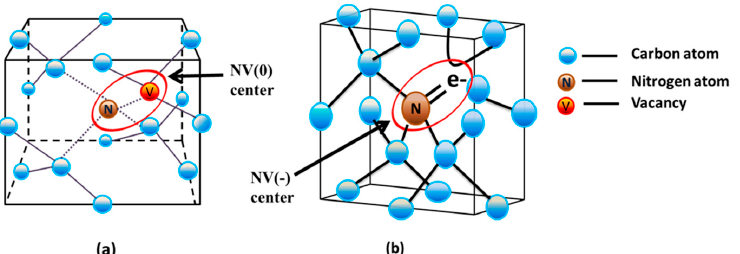
Figure 1. Schematic of ( a ) NV(0) center and ( b ) NV( − ) center in a diamond unit cell. NV: nitrogen-vacancy.